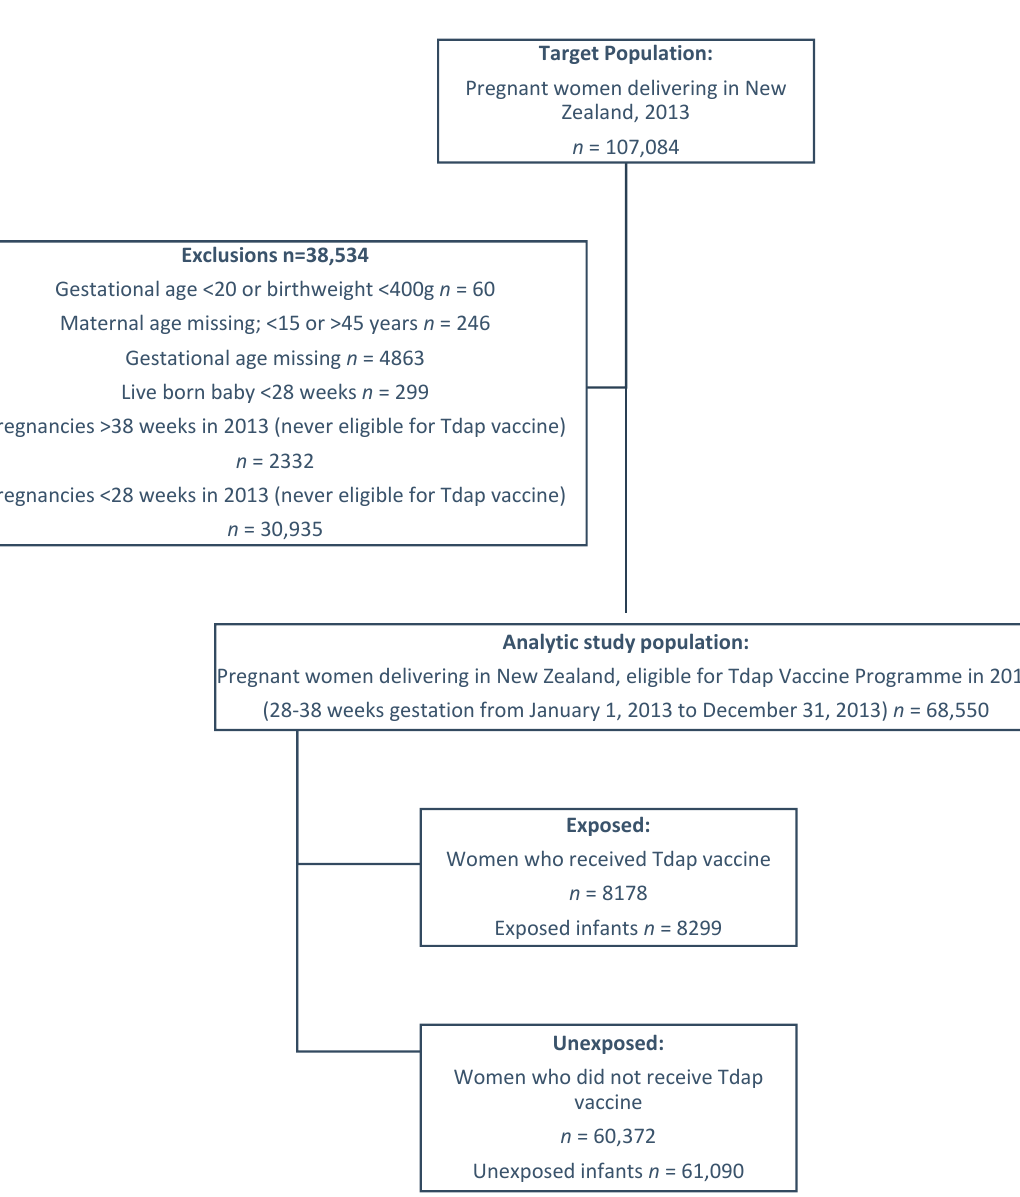
Figure 1. Flow of study